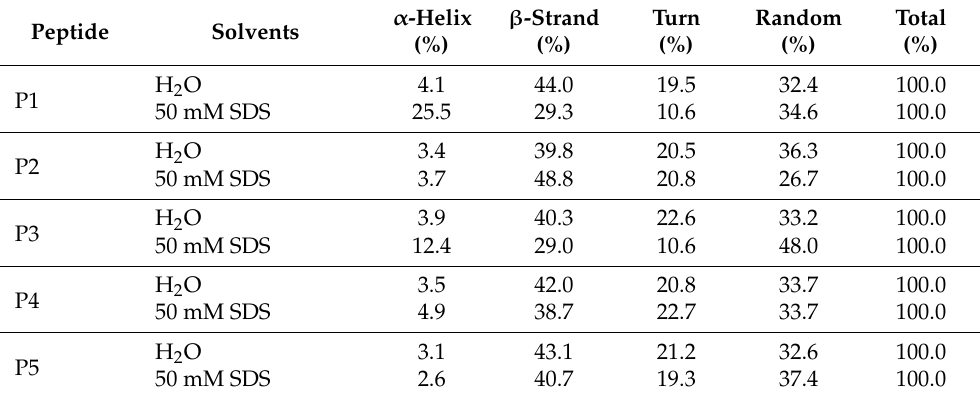
Table 4. Estimation of secondary structure content of anti-MRSA peptides. The peptides were dissolved in the different solvents (deionized water and 50 mM SDS), and the predicted secondary structures were analyzed by the CONTINLL program. α -Helix Peptide Solvents